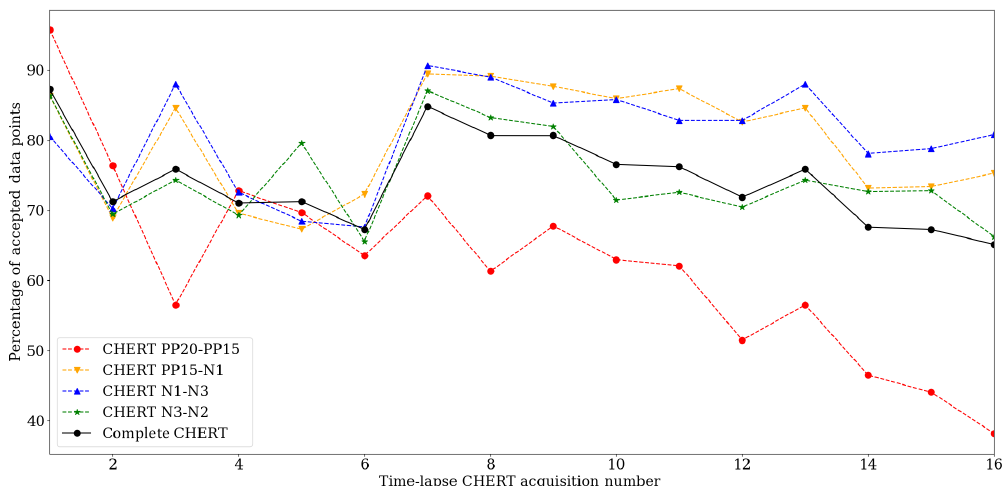
Figure 5. Percentage of accepted data points in each CHERT, after quality control during data pre-processing. Note the decrease in the amount of accepted data with time, most likely due to corrosion of the electrodes, particularly in the PP20-PP15 panel, which is located the closest to the